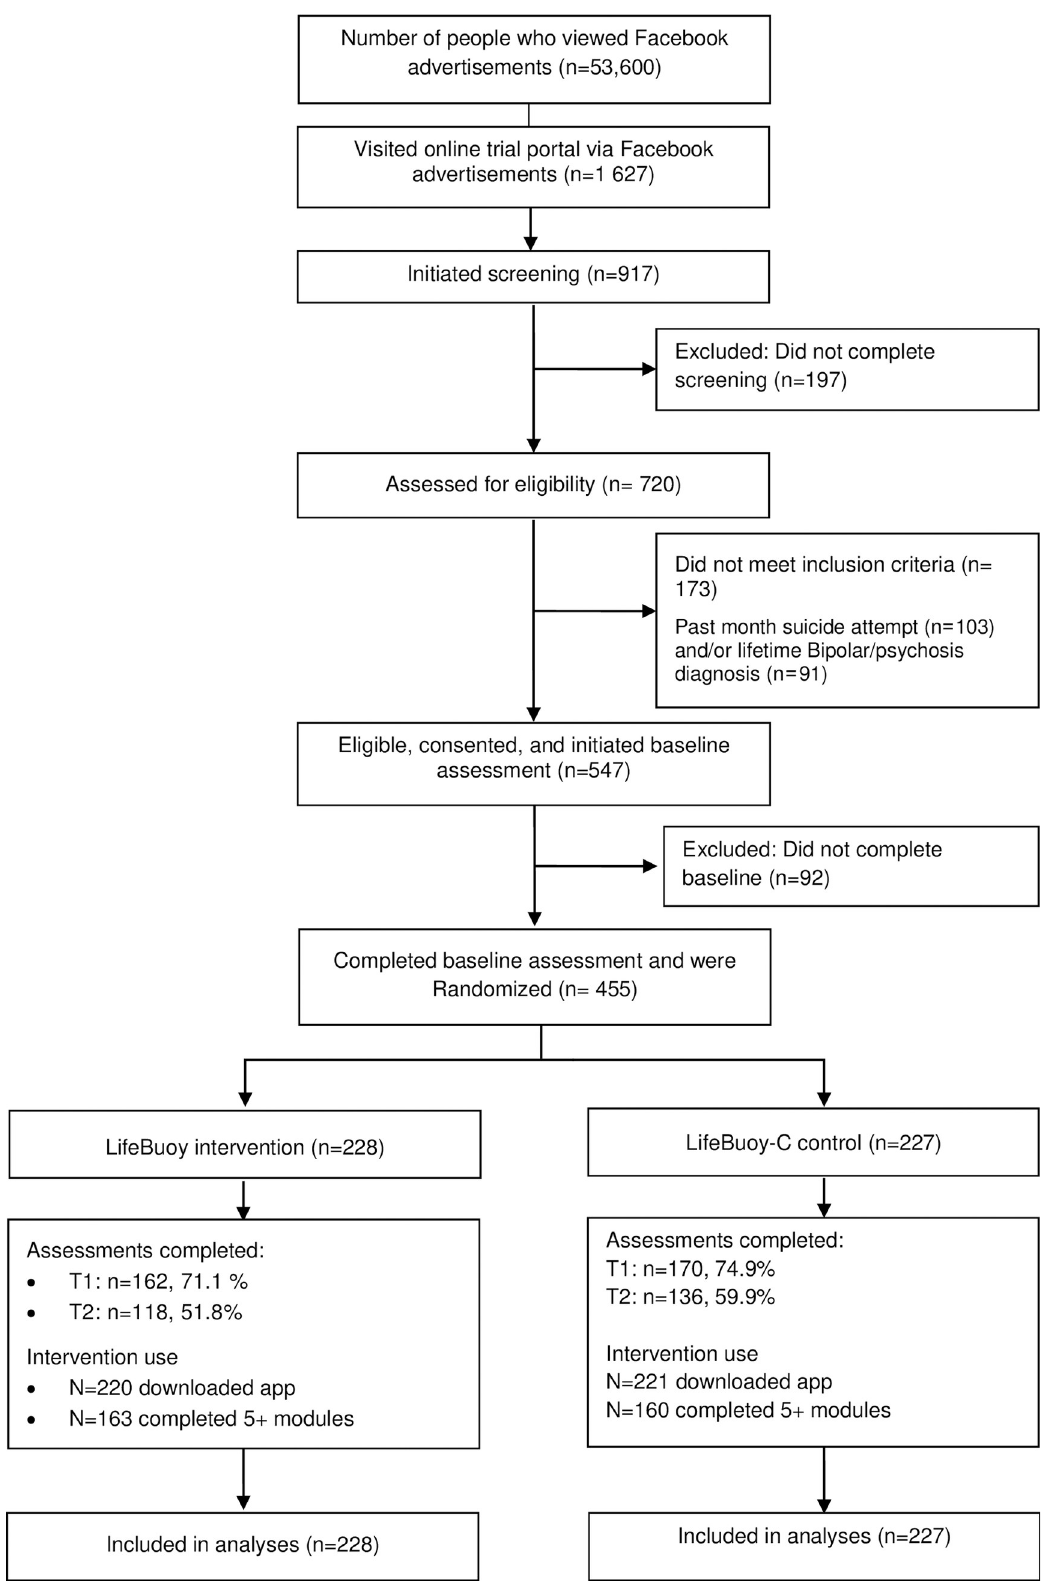
Fig 1. CONSORT trial flow. C AU : AbbreviationlistshavebeencompiledforthoseusedthroughoutFigs 1 and 2 : Pleaseverifythatallentriesarecorrect : ONSORT, Consolidated Standards of Reporting Trials. https://doi.org/10.1371/journal.pmed.1003978.g001 PLOS Medicine| https://doi.org/10.1371/journal.pmed.1003978 May 31,